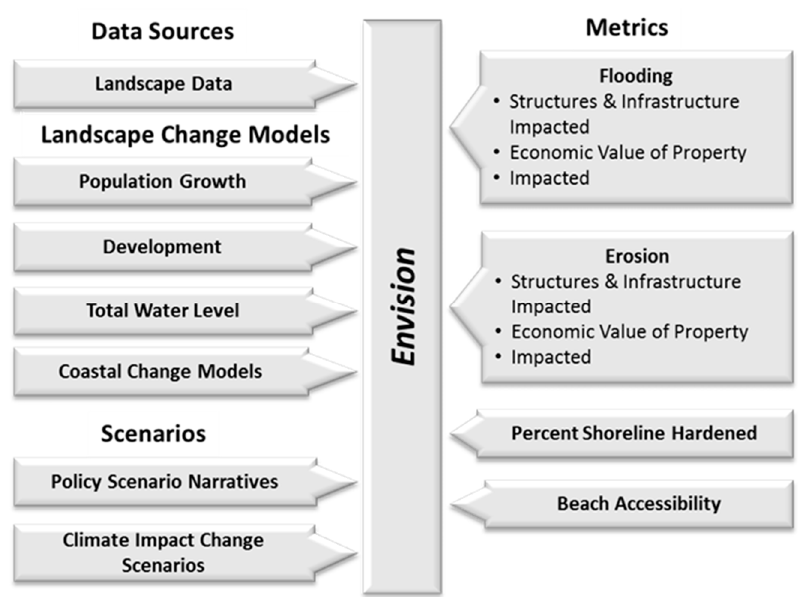
Figure 2. Envision inputs, landscape change models, and evaluative models specific to the model- of coastal hazards in Tillamook County, Oregon from ing of coastal hazards in Tillamook County, Oregon from [43].